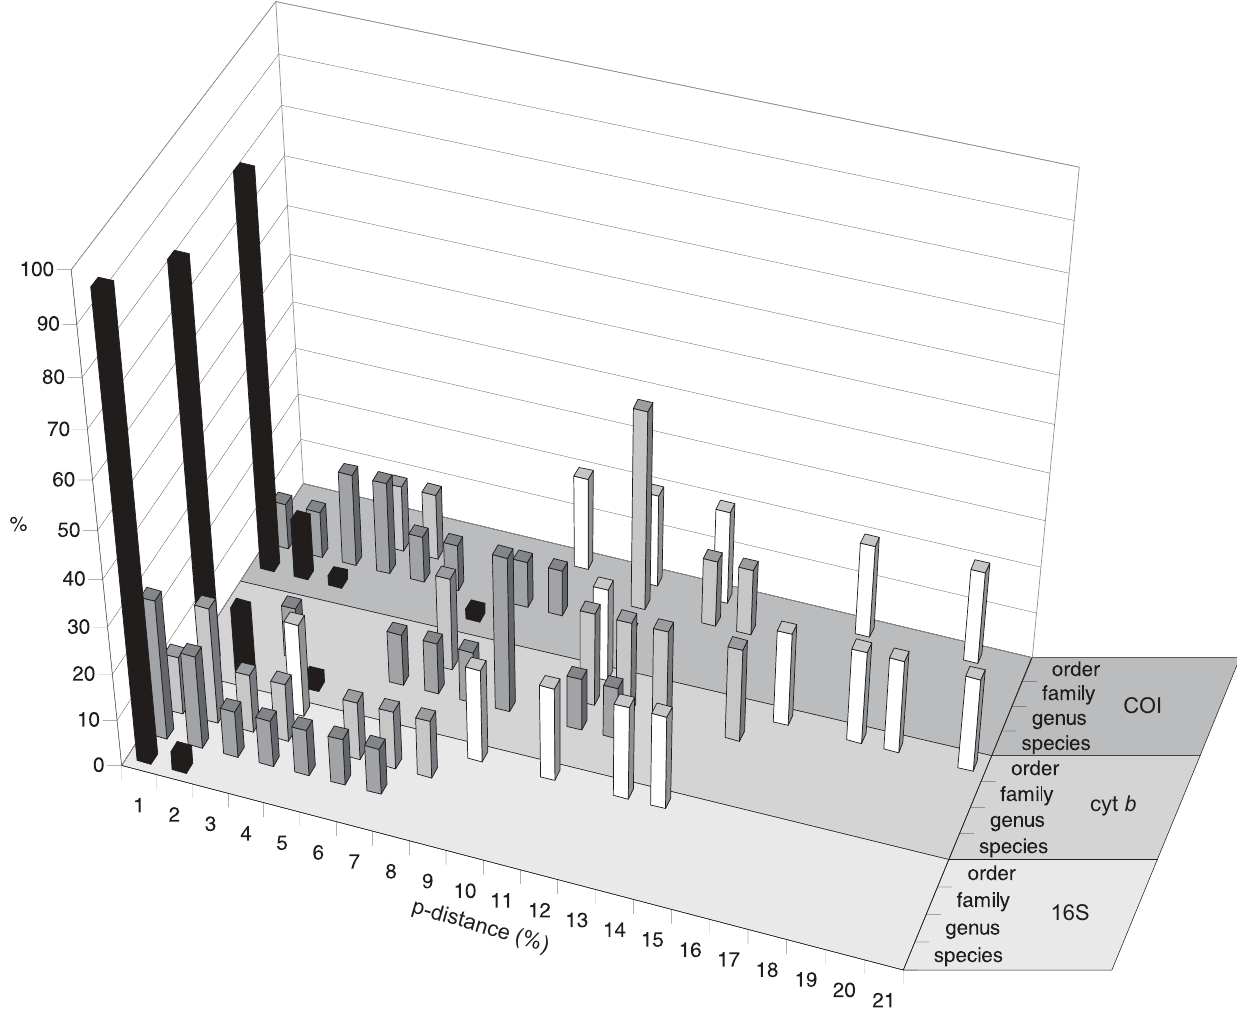
Figure 2. Frequency distribution of genetic p-distances. Data for different taxonomic levels for partial sequences from mitochondrial 16S rRNA (16S), cytochrome b (cyt b ), and cytochrome oxidase subunit I (COI) genes of fishes from European seas.